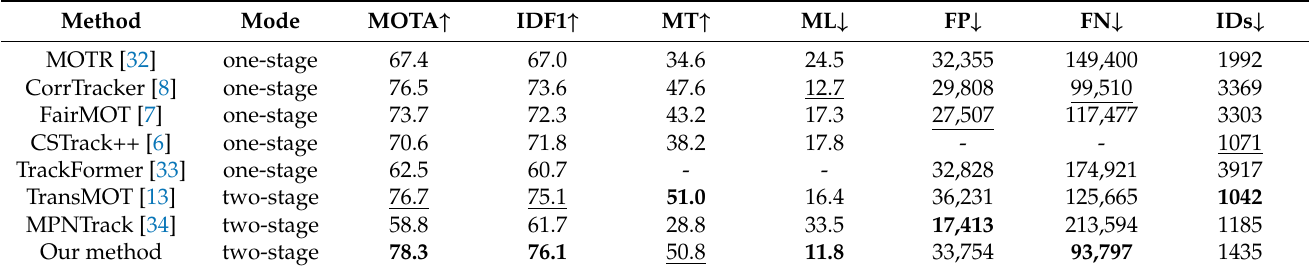
Table 1. Comparison with the state-of-the-art methods over the dataset MOT17 test set. The best results are shown in bold . The next best result is underlined.